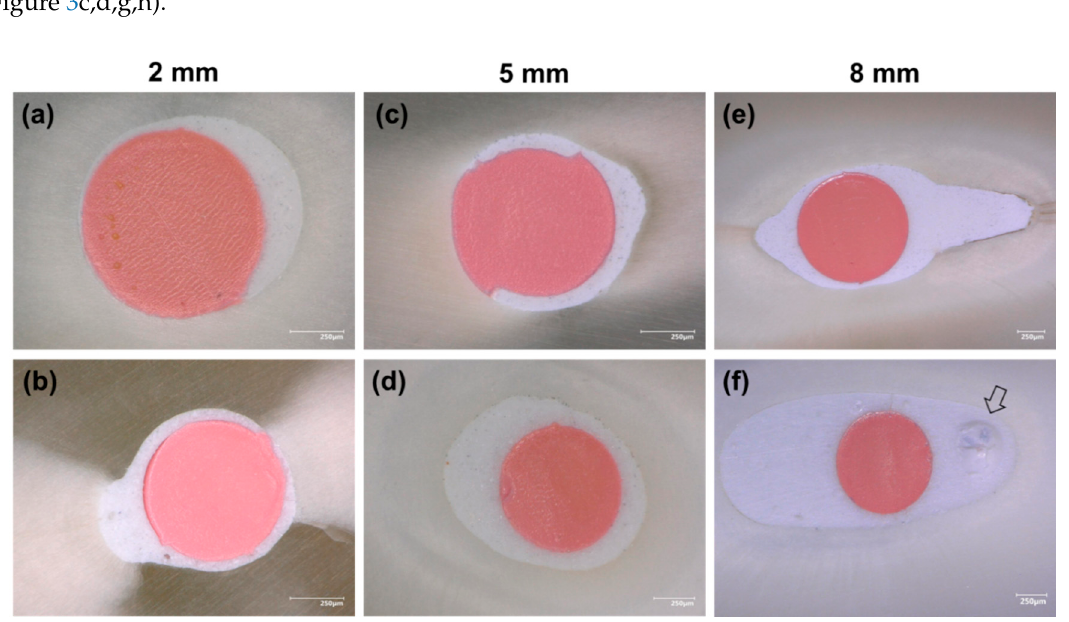
Figure 2. Digital microscope images. ( a ) Ceraseal, ( b ) BioRoot at 2 mm from the apex (200× magnification); ( c ) Ceraseal, ( d ) BioRoot at 5 mm from the apex (200× magnification); ( e ) Ceraseal, ( f ) BioRoot at 8 mm from the apex (100 × magnification), showing an internal void (closed pores) Table 2. Gutta-percha filling area (GPFA), sealer area, and void (interfacial and intracanal voids) percentages in the samples at 2, 5, and 8 mm from the working length.